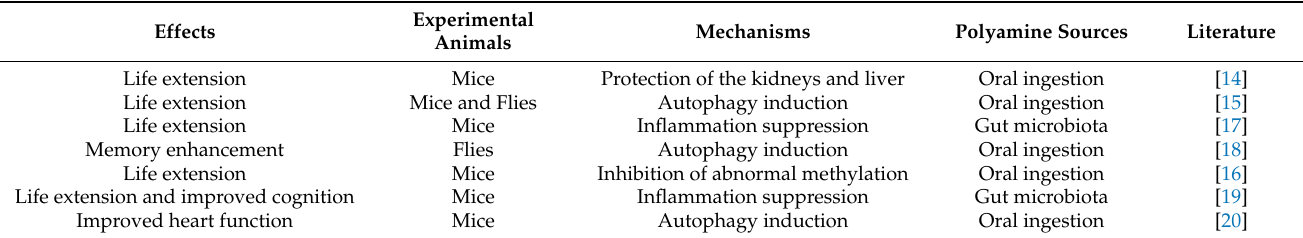
Table 1. Health promotion and life extension by